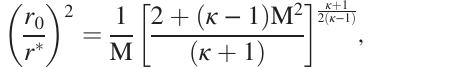
FIG. 3. The plasma electron number density n e , 1 mm from the nozzle orifice (2 mm diameter) as a function of the applied backing pressure ( p 0 ) for H 2 (blue circles) and He (red crosses). Assuming full ionization, the plateau electron number density n e along the center axis in the laser propagation direction is determined from measurements of the neutral gas number density ( n ) using a setup consisting of an expanded HeNe beam and a wave-front sensor. Each point represents the average of 10 – 20 individual measurements, and the error bars indicate one standard deviation in each direction. The dashed lines are the theoretical results fitted with regards to r (cid:2) of the nozzle. The fitted results, shown as dashed lines in Fig. 3, are in excellent agreement with the experimen- tal data.